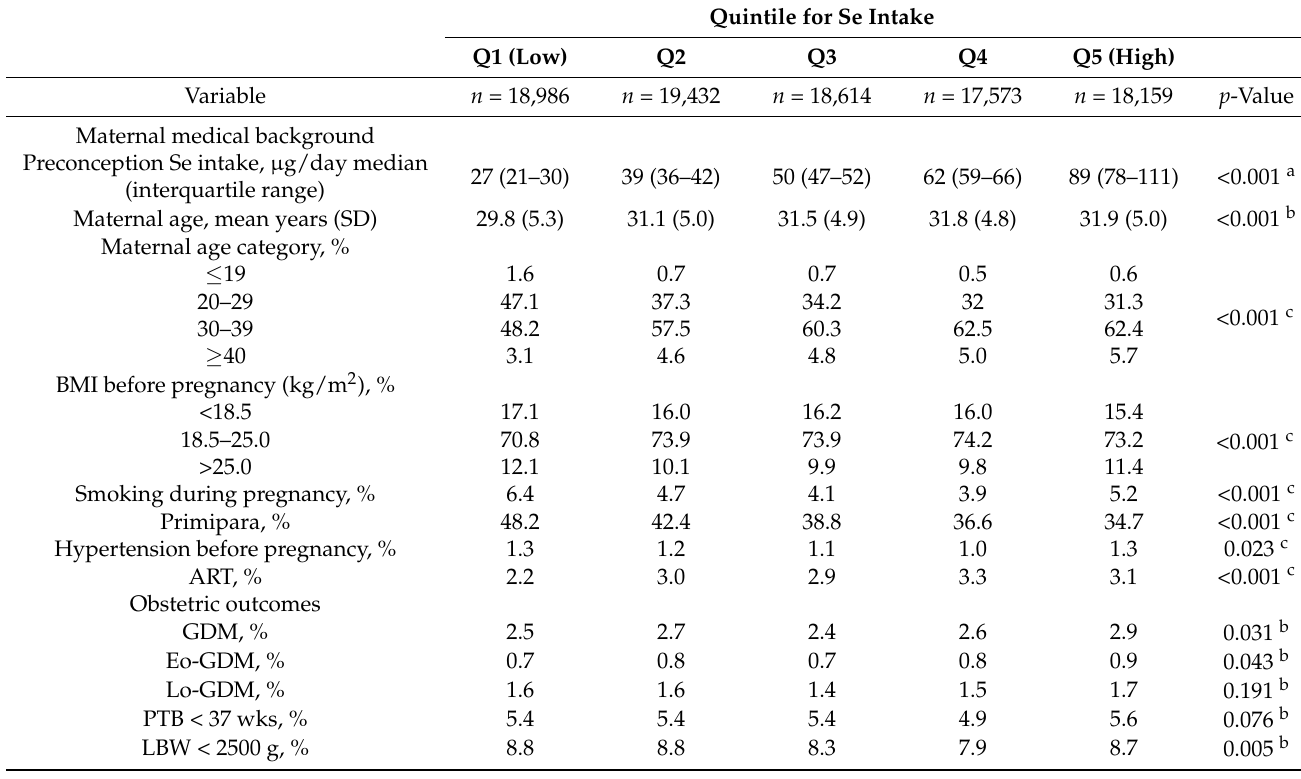
Table 1. Maternal basic background and obstetric outcomes according to the quintile for preconception Se